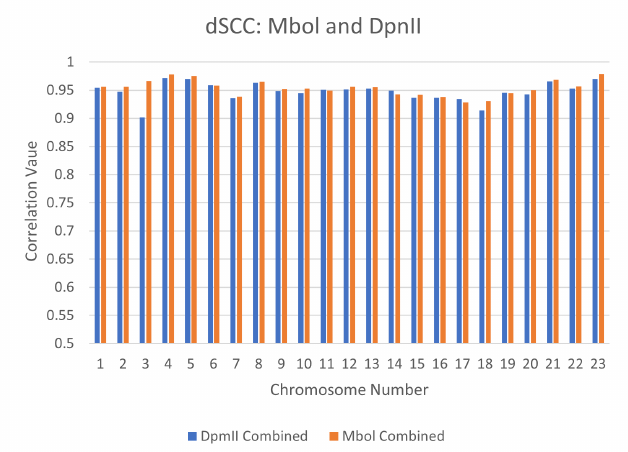
Figure 16. Comparison of the output dSCC for CBCR utilizing the Mbol and DpnII restriction enzymes at 1mb resolution.